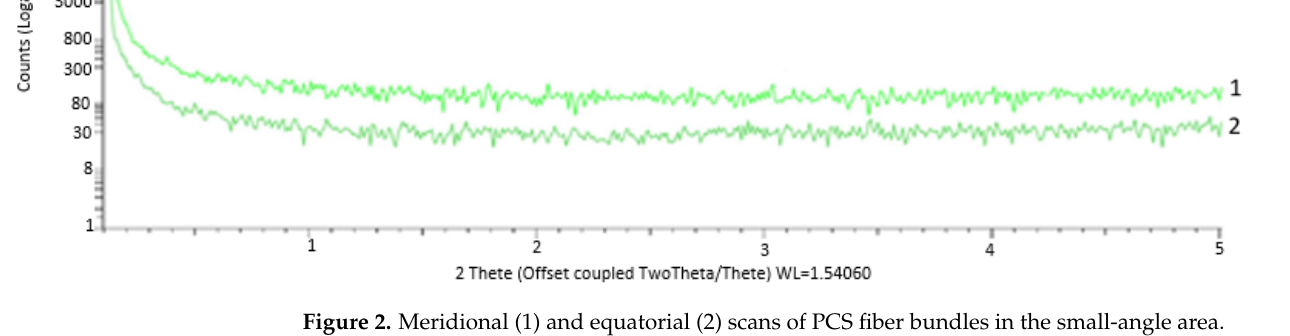
Figure 2. Meridional (1) and equatorial (2) scans of PCS fiber bundles in the small-angle area. Microtomography of the polymer fibers shows no systematic difference in the near- surface and intra-volume areas (Figure 3).